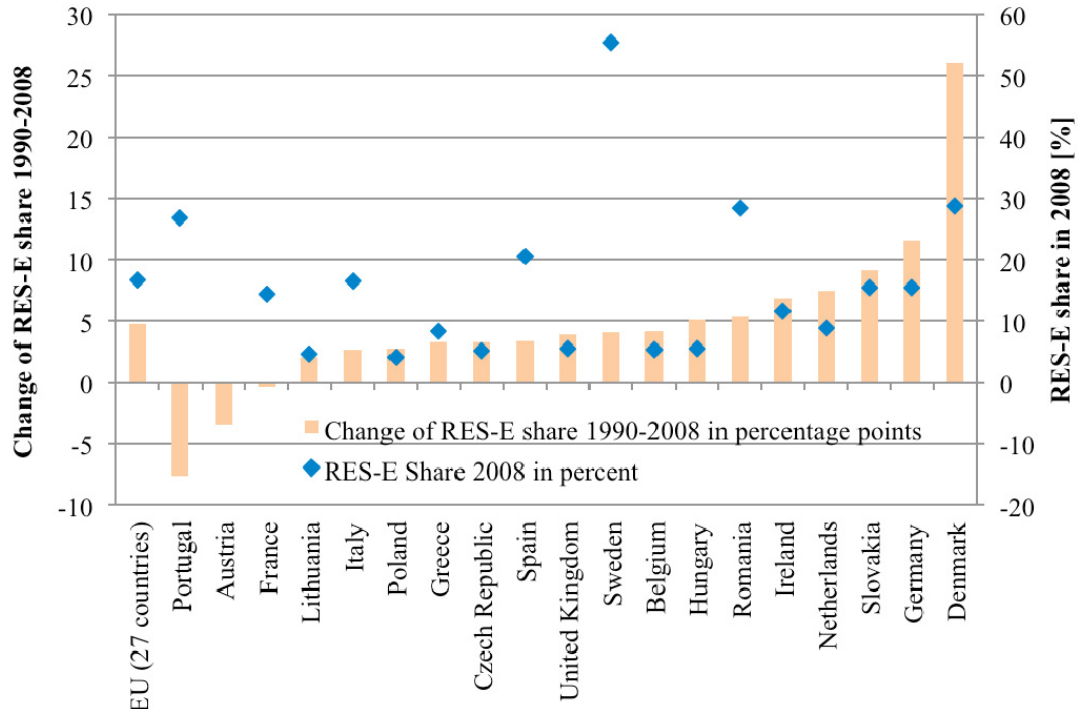
Figure 1. Share of gross electricity consumption generated from renewable energy sources